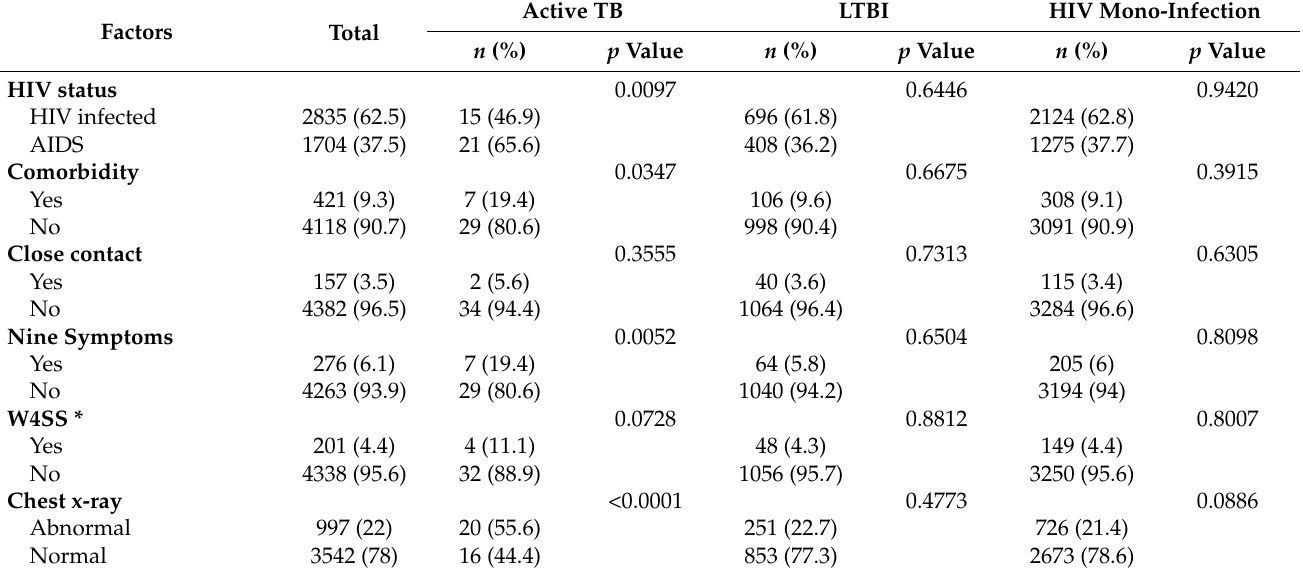
Table 3. Clinical characteristics of HIV/AIDS outpatient in Guangxi province.